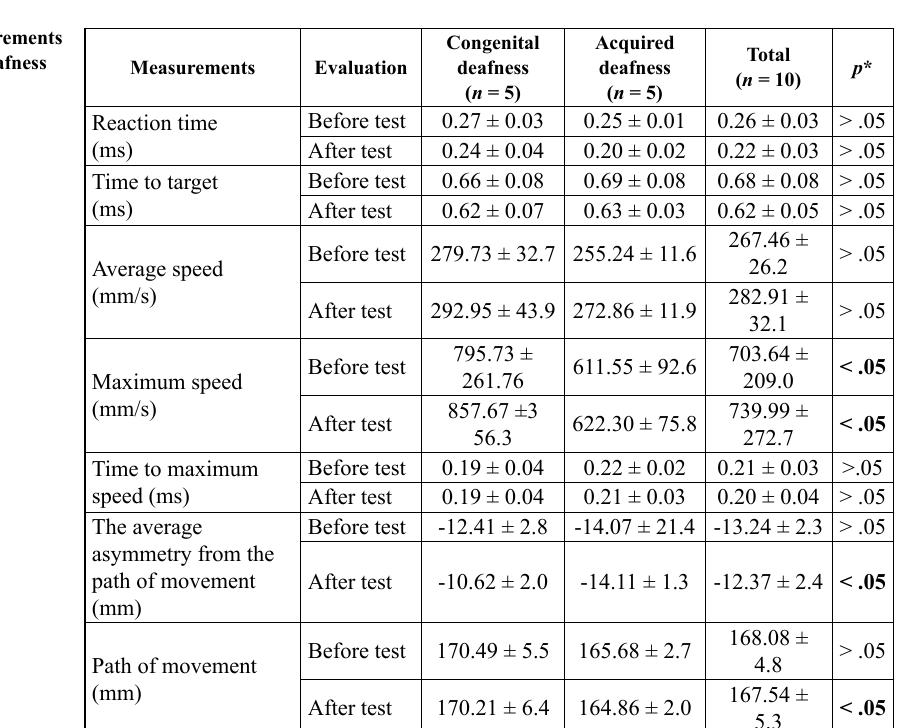
Note. * – Mann–Whitney U test.